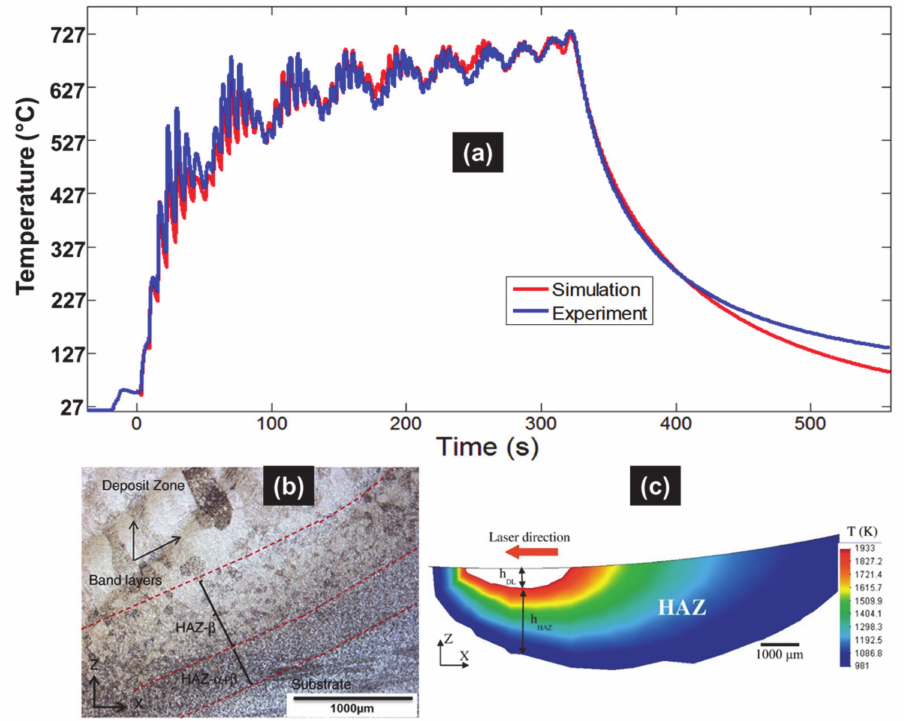
Figure 9. ( a ) Predicted and measured temperature–time curves at the thermocouple inside the substrate for 10 layers. ( b ) Estimation of deposition features (dilution zone, HAZ) at the first layer and the mid-width of the substrate beneath the thick Ti6Al4V deposit obtained by DED, with parameters measured by metallographic inspection (Reprinted with permission from ref. [5]. Copyright 2015 Elsevier); ( c ) parameters predicted using the validated thermal model (Reprinted with permission from ref. [38]. Copyright 2017